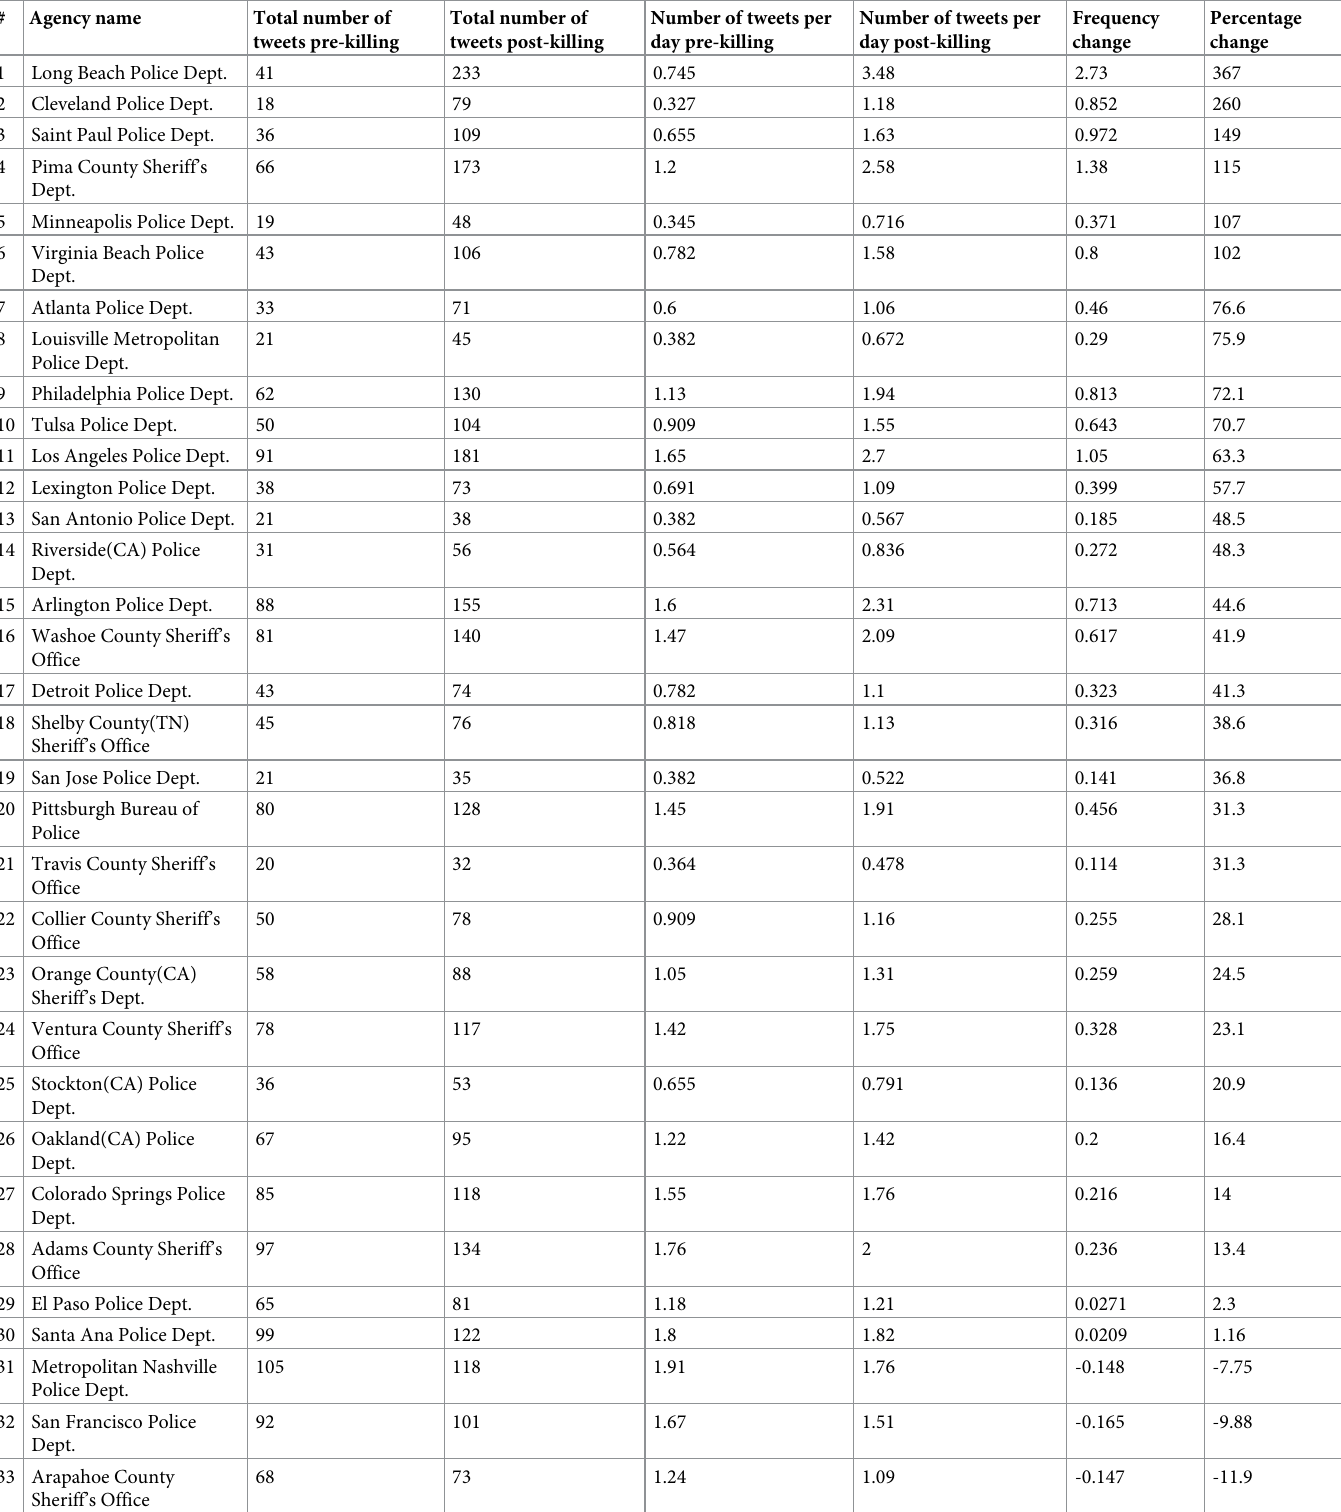
Table 4. Agencies (in the lower-use group) ranked by the increase in the number of tweets posted before and after the killing. Total number of tweets